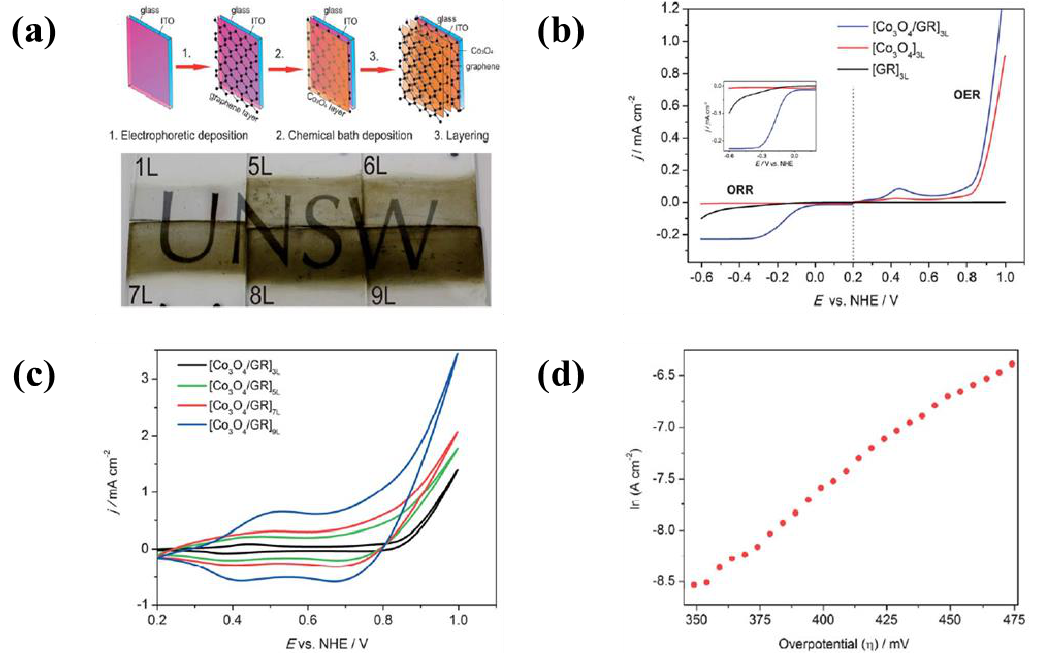
Figure 31. ( a ) Fabrication scheme of a bi-layer composite electrode; ( b ) Linear sweep voltammograms of by-layer composite electrode (red), Co 3 O 4 nanoparticles electrode (blue), graphene electrode (black). The inset shows the magnified ORR region; ( c ) Cyclic voltammograms obtained at a scan rate of 10 mV · s − 1 with different numbers of bi-layers in a bi-layer composite electrode; ( d ) Tafel plot generated from water oxidation using the bi-layer composite electrode of 9 layers.